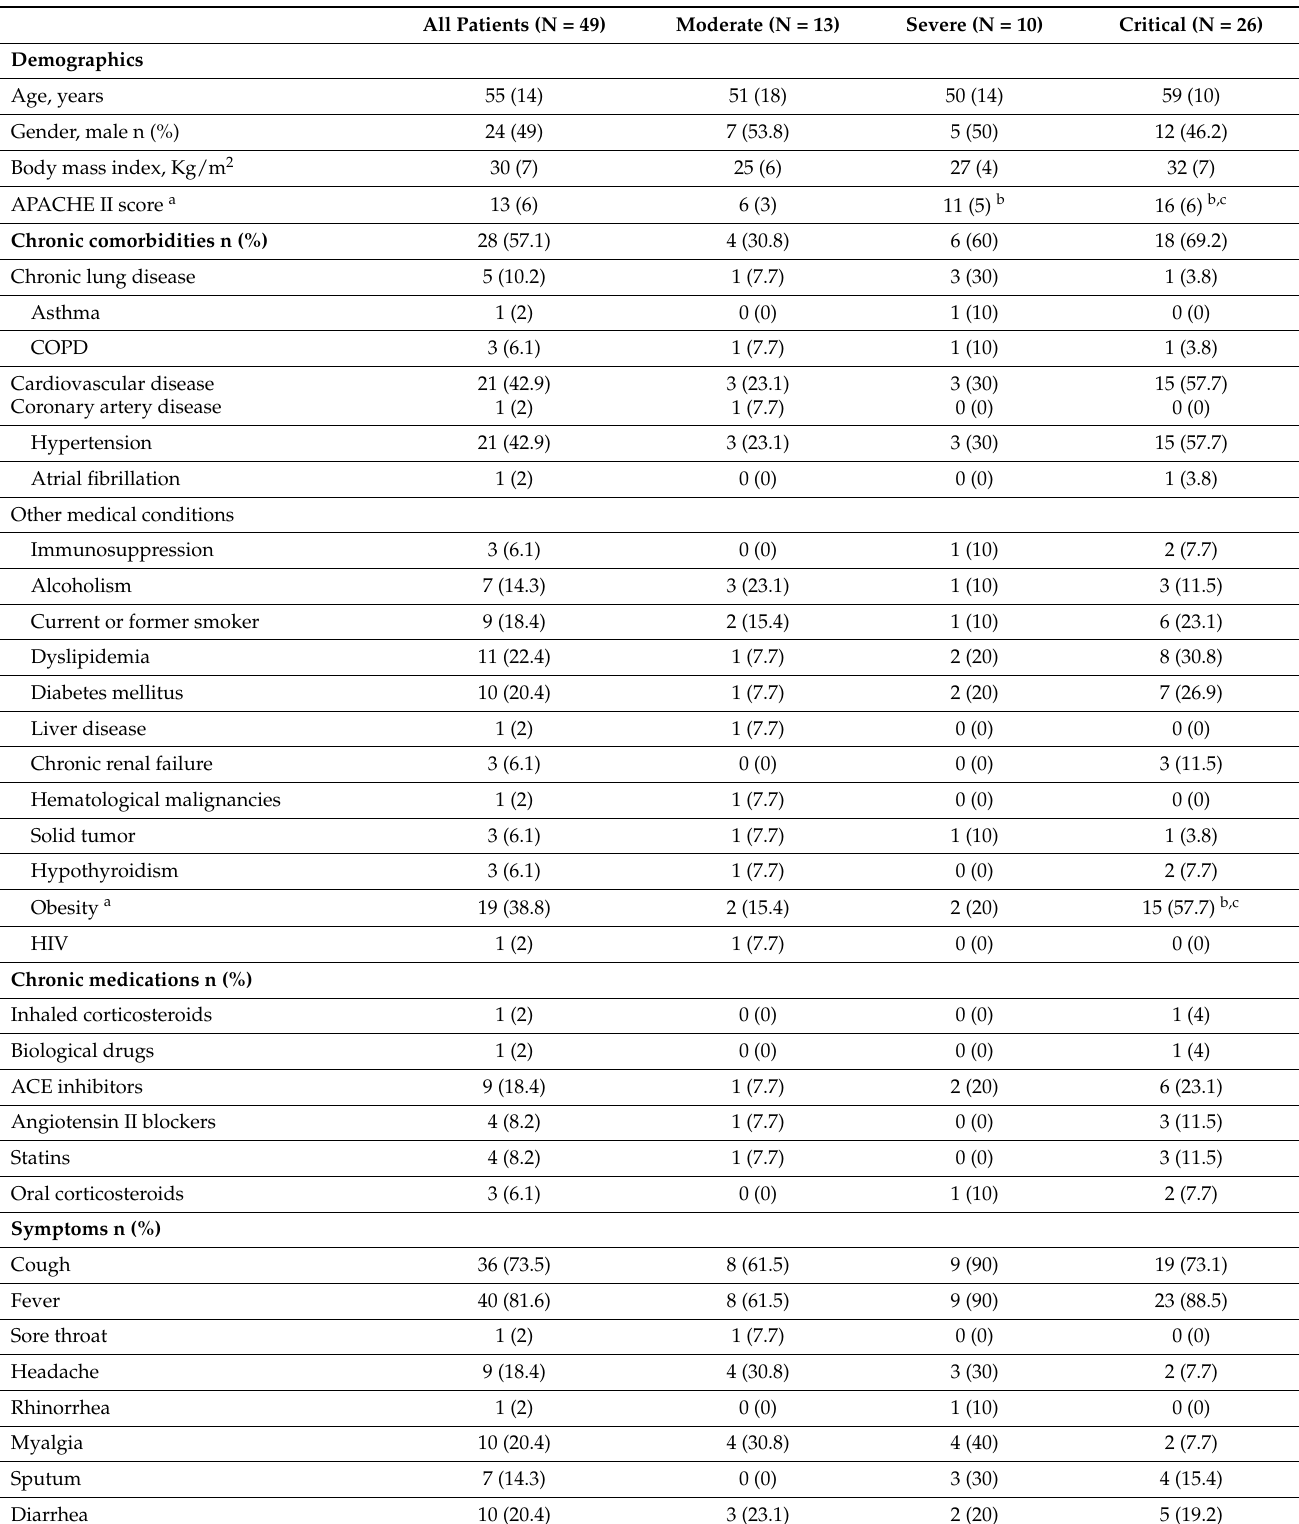
Table 1. Characteristics of hospitalized COVID-19 patients included in the study by